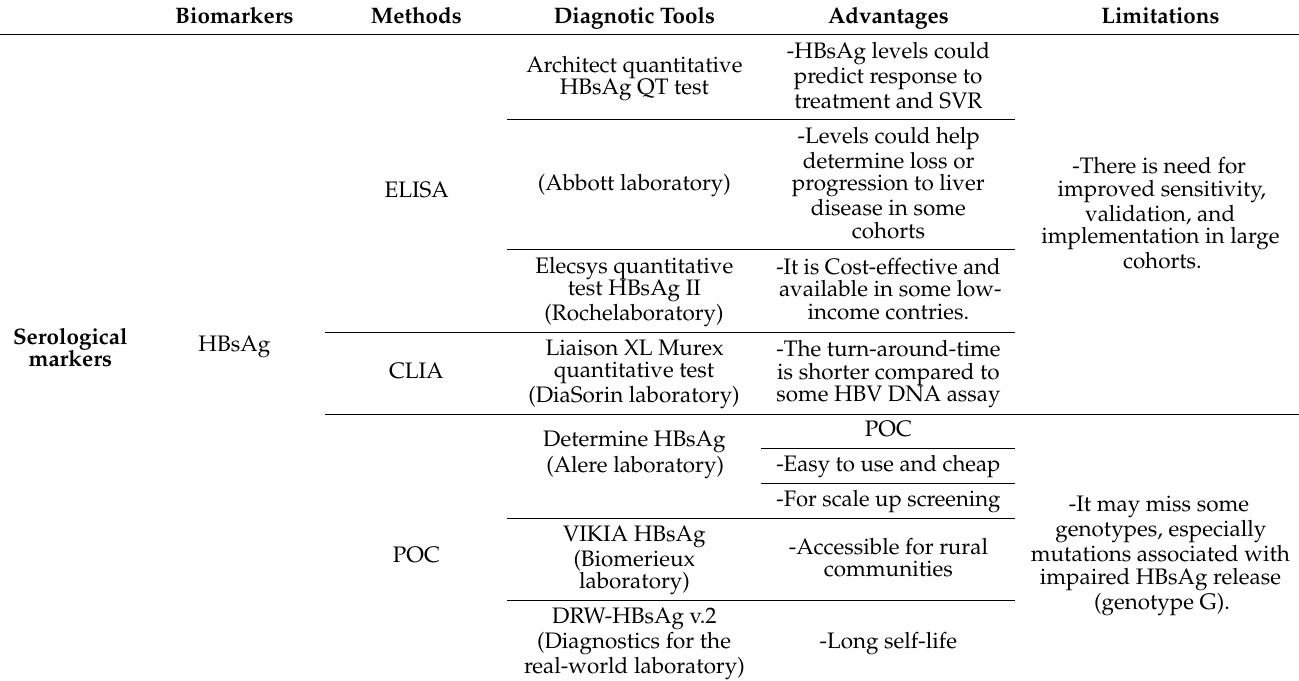
Table 3. Tools and markers that could be used for HBV and HDV diagnosis in resource limited countries.